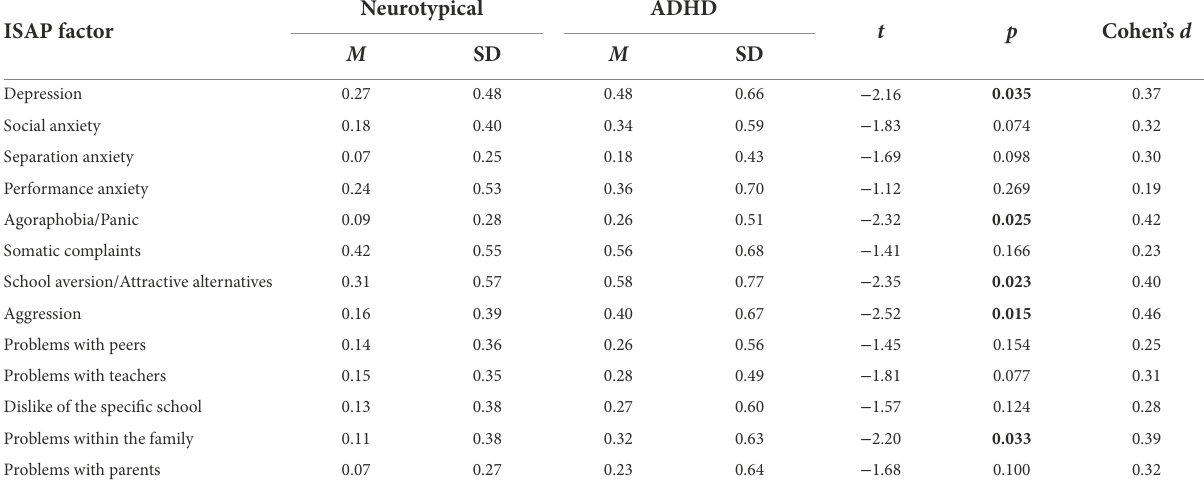
TABLE 3 Means, standard deviations and differences in function of symptom between adolescents with or without ADHD.